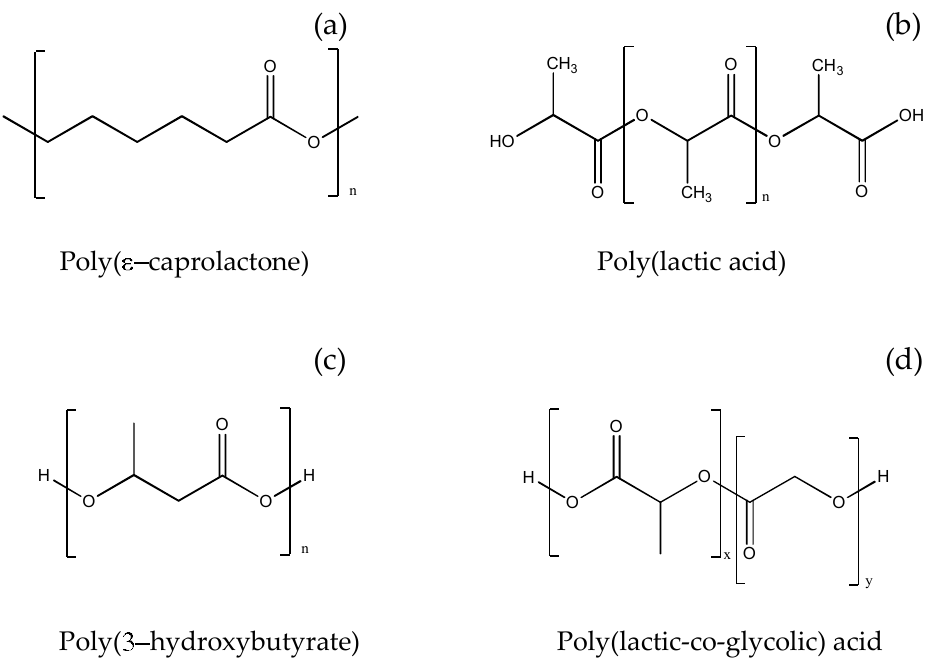
Figure 2. Chemical structure of ( a ) PLC; ( b ) PLA; ( c ) PHB; ( d ) PLGA.